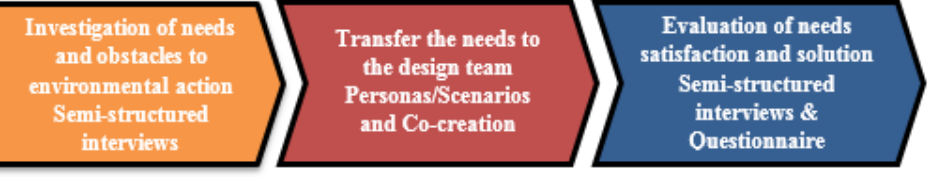
Fig. 1. Social research phases of the